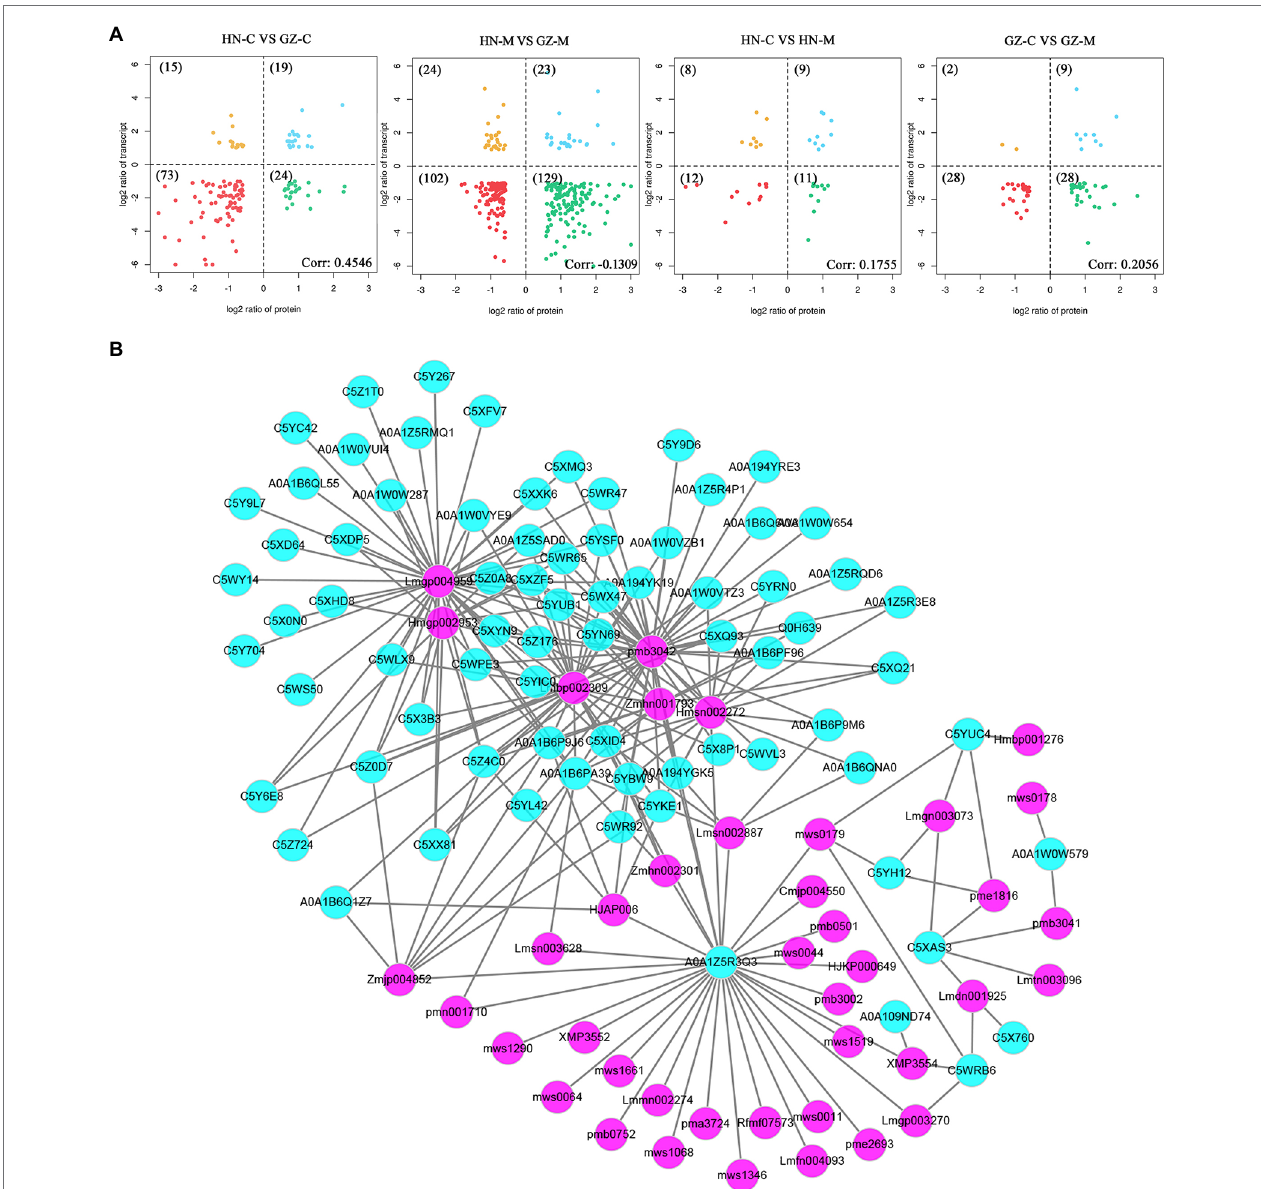
FIGURE 6 | Multi-omics analyses of GZ and HN under salt treatments. (A) Four-quadrant diagram analysis between the common DEGs and the common DEPs in sorghum in response to salt. (B) Correlation network constructed with the common DEPs (green) and the common DAMs (purple) under salt stress ( R 2 >